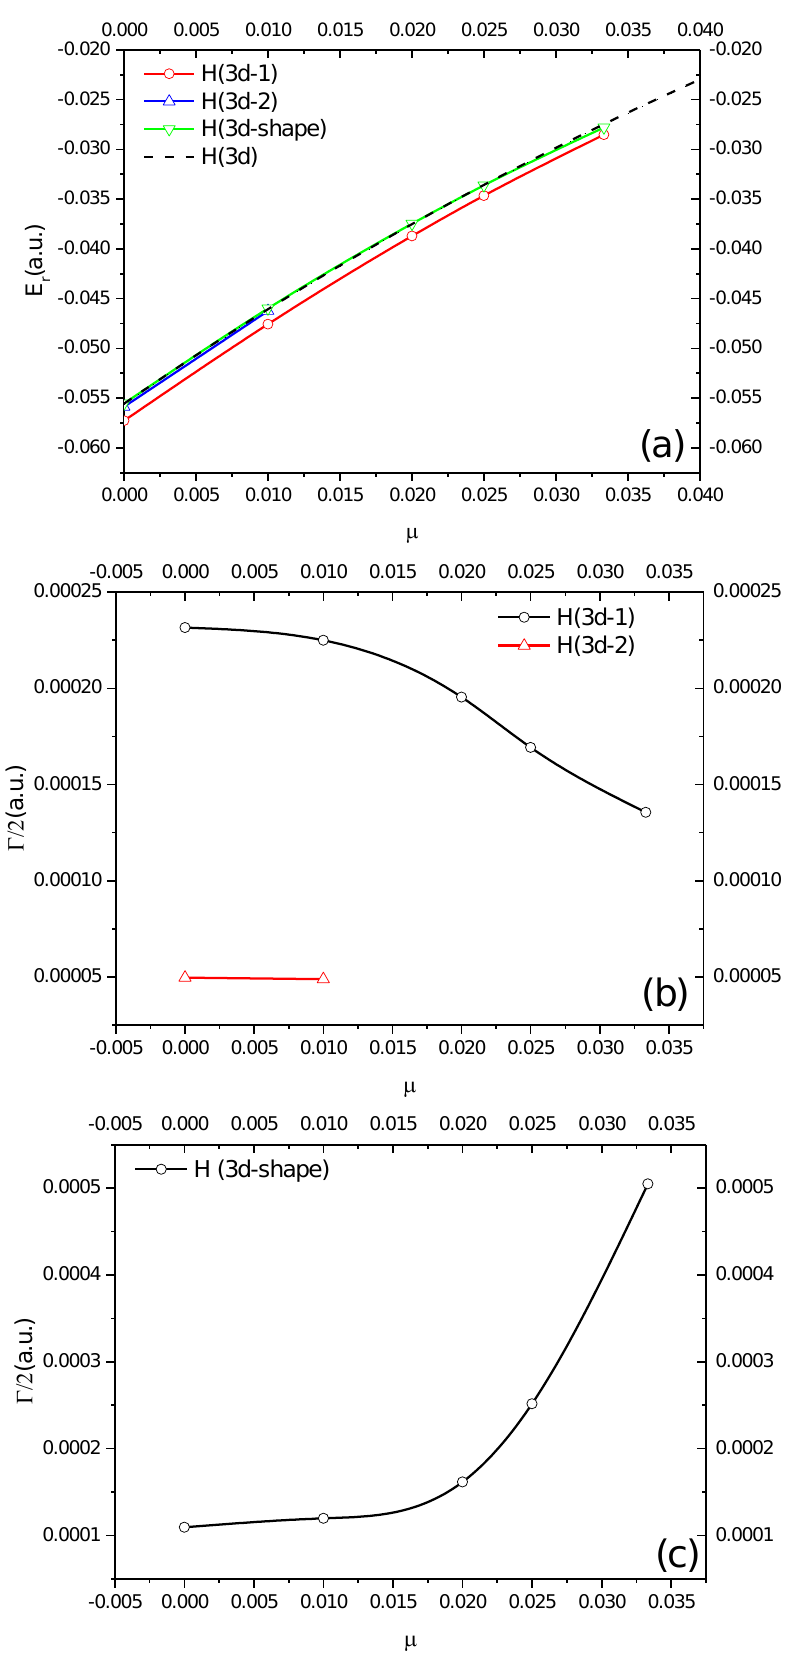
Figure 3. D -wave ( a ) resonance energy and ( b ) half-width for the H(3d- k ) states with k = 1, 2, and ( c ) shape resonance, as a function of μ = 1/ D .